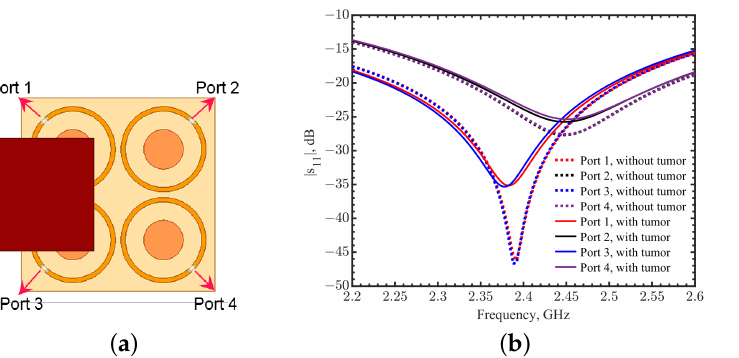
Figure 21. ( a ) Setup to investigate the impact of steered fields by changing the phase difference in the array. A tumor was placed off-center, symmetrically but partly underneath loops 1 and 3 at a depth of 10 mm. ( b ) Comparison of reflection coefficients at ports with and without a tumor underneath the